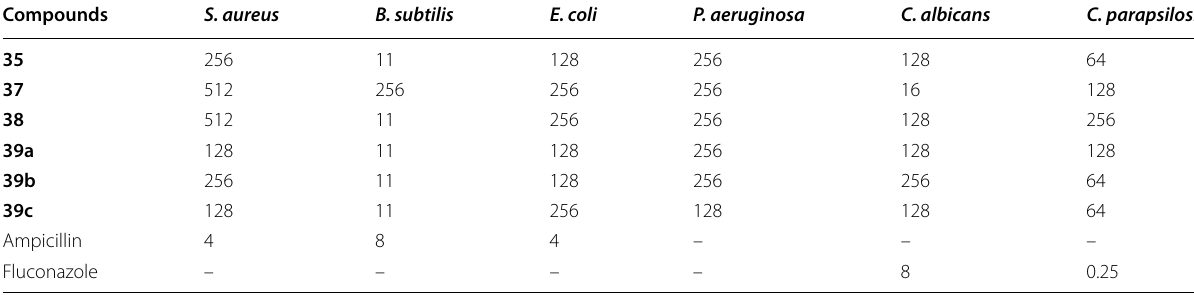
Table 9 Antibacterial and antifungal activities of the compounds as MIC values (μg/ml)